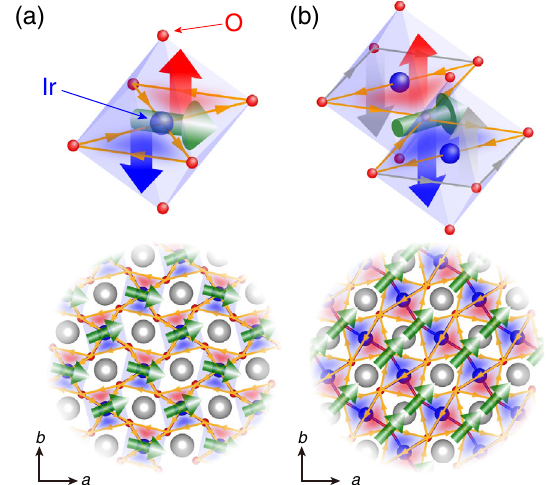
FIG. 4. (a) Upper figure: loop currents (thin orange arrows), induced magnetic fields (thick red and blue arrows), and anapole vector (green arrow) in the IrO 6 octahedron. The net anapole vector is along the [100] Ir-Ir direction. The lower figure is the top view of the upper figure. (b) Same as (a), but the loop current pattern is different. The anapole vector is along the [110] Ir-O-Ir bond